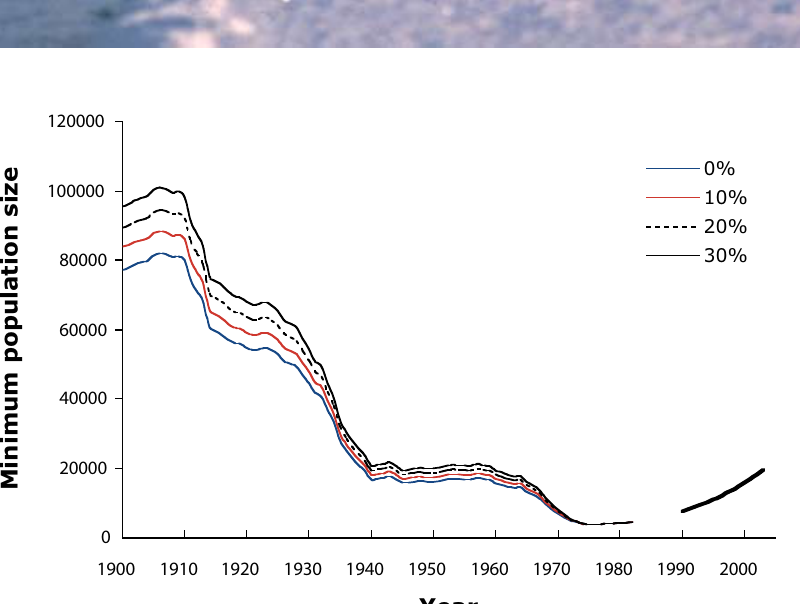
Fig. 1. Grey seals often maintain breath - ing holes in the Baltic sea ice. (Photo: Olle